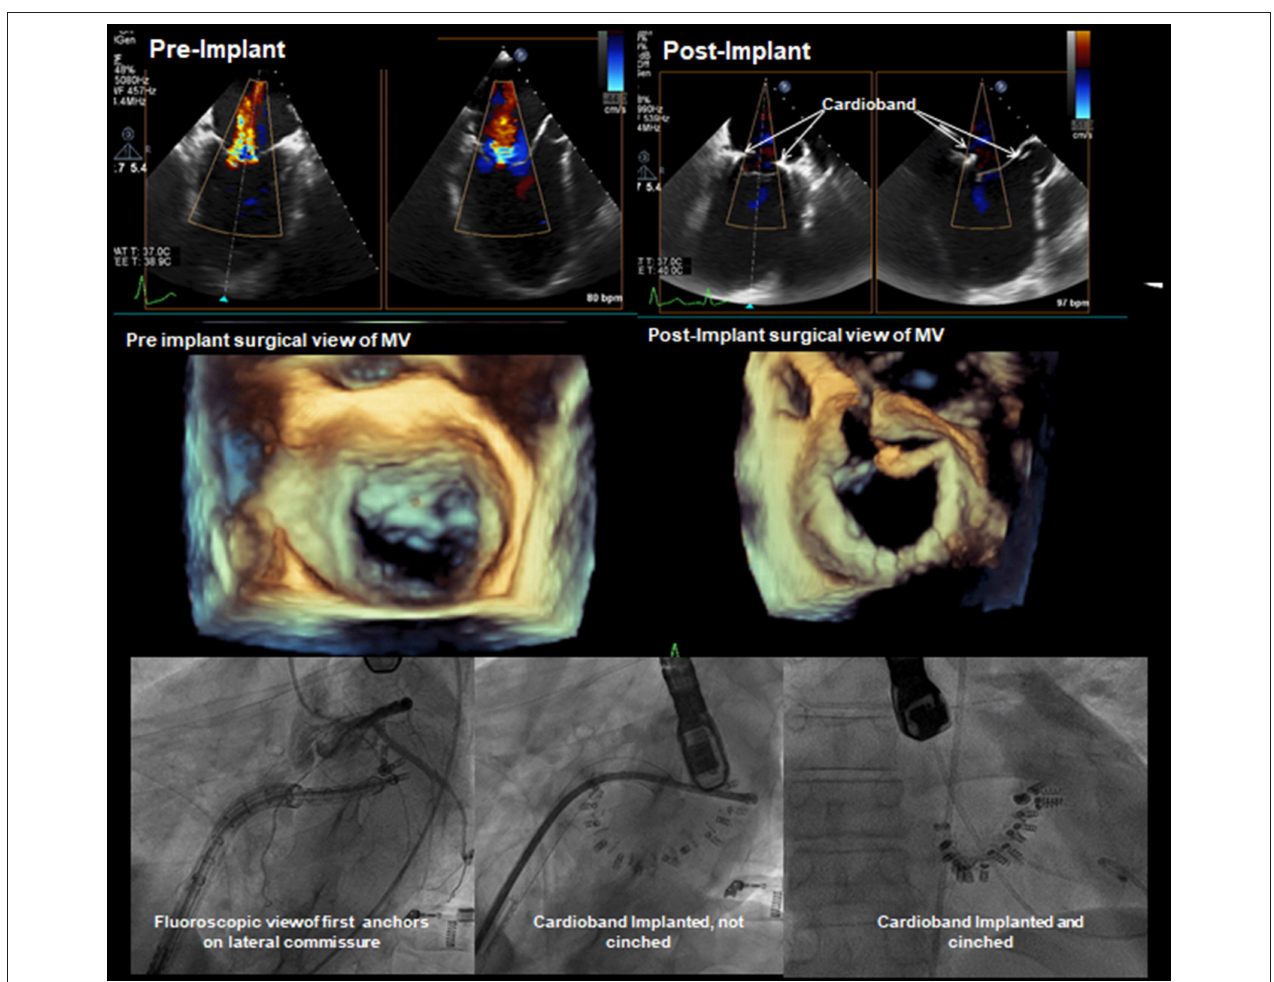
FIGURE 12 | Pre- and post-implantation echo and fluoroscopy images. TEE 2-CH and LAX projections demonstrating visibly reduced regurgitation jet. Fluoro images showing the process of deployment and clinching of the annuloplasty ring concluded with a successful